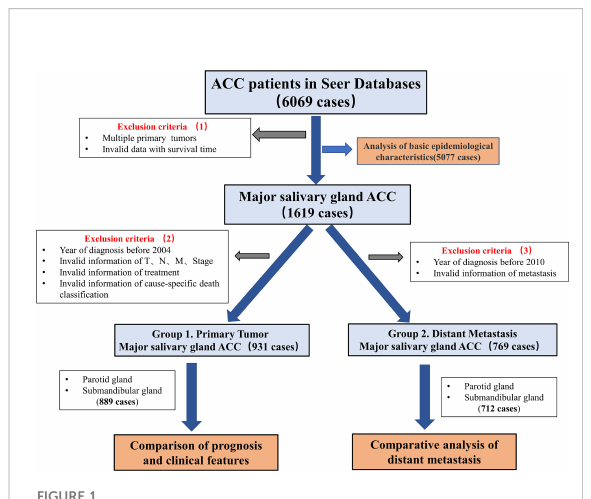
FIGURE 1 Flow chart showing the screening process for data from the SEER database. The dataset “ Incidence-SEER Research Plus Data, 18 Registries, Nov 2020 Sub (2000-2018) ” , including a total of 6069 patients with ACC, was selected based on screening criteria 1. The basic epidemiological characteristics of 5077 ACC patients with complete information were analysed. Then, a total of 1619 patients with major salivary glands ACC were selected. According to screening criteria 2, patients with missing basic clinical characteristics were excluded from the 1619 patients for the analysis of the differences in clinical characteristics to determine the prognosis. According to screening criteria 3, 769 patients were selected from the original 1619 patients, and distant metastasis was